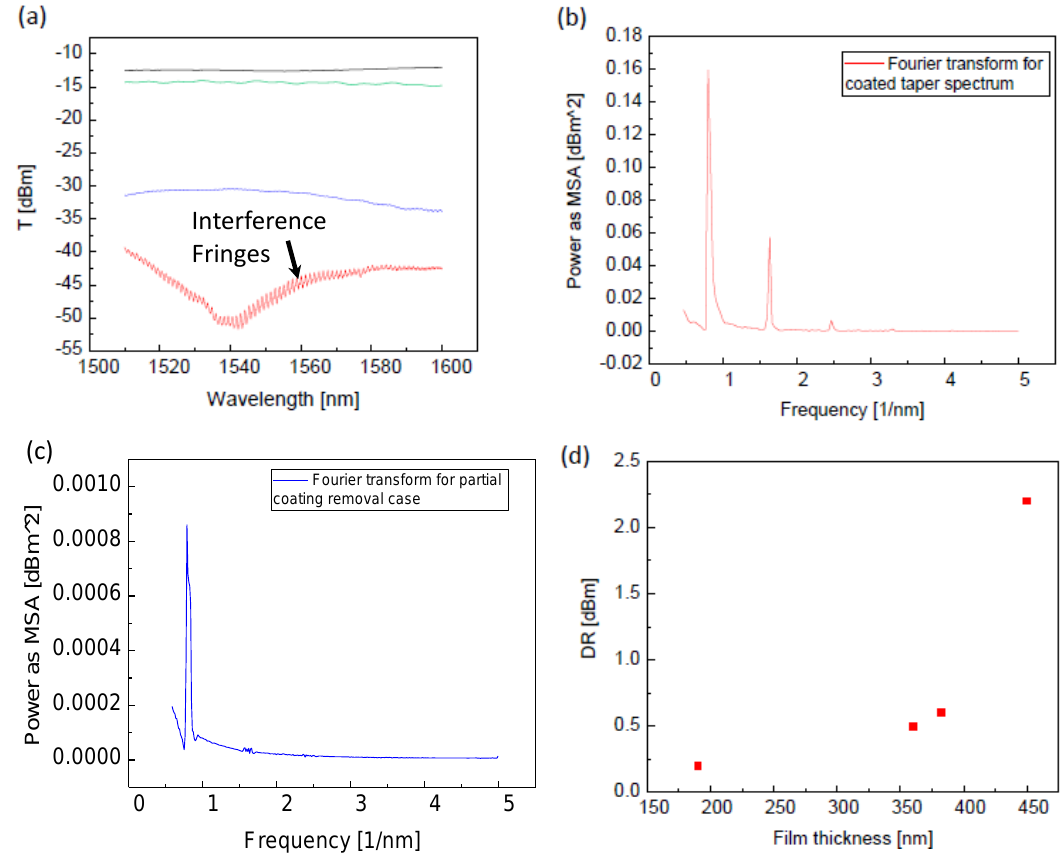
Figure 4. ( a ): IR transmission spectra of the uncoated taper (black line), fully coated taper (red line), and after slow coating removal in Acetone vapor exposure: blue line—after 2 h, green line—after 2 days. ( b ): Fourier transform of the fully coated taper spectrum. ( c ): Fourier transform of the spectrum after first coating removal. FFT spectra are given in Mean Square Amplitude (MSA) Power as a function of spatial frequency in (1/nm). ( d ): Dynamical range of the patterns as a function of the film